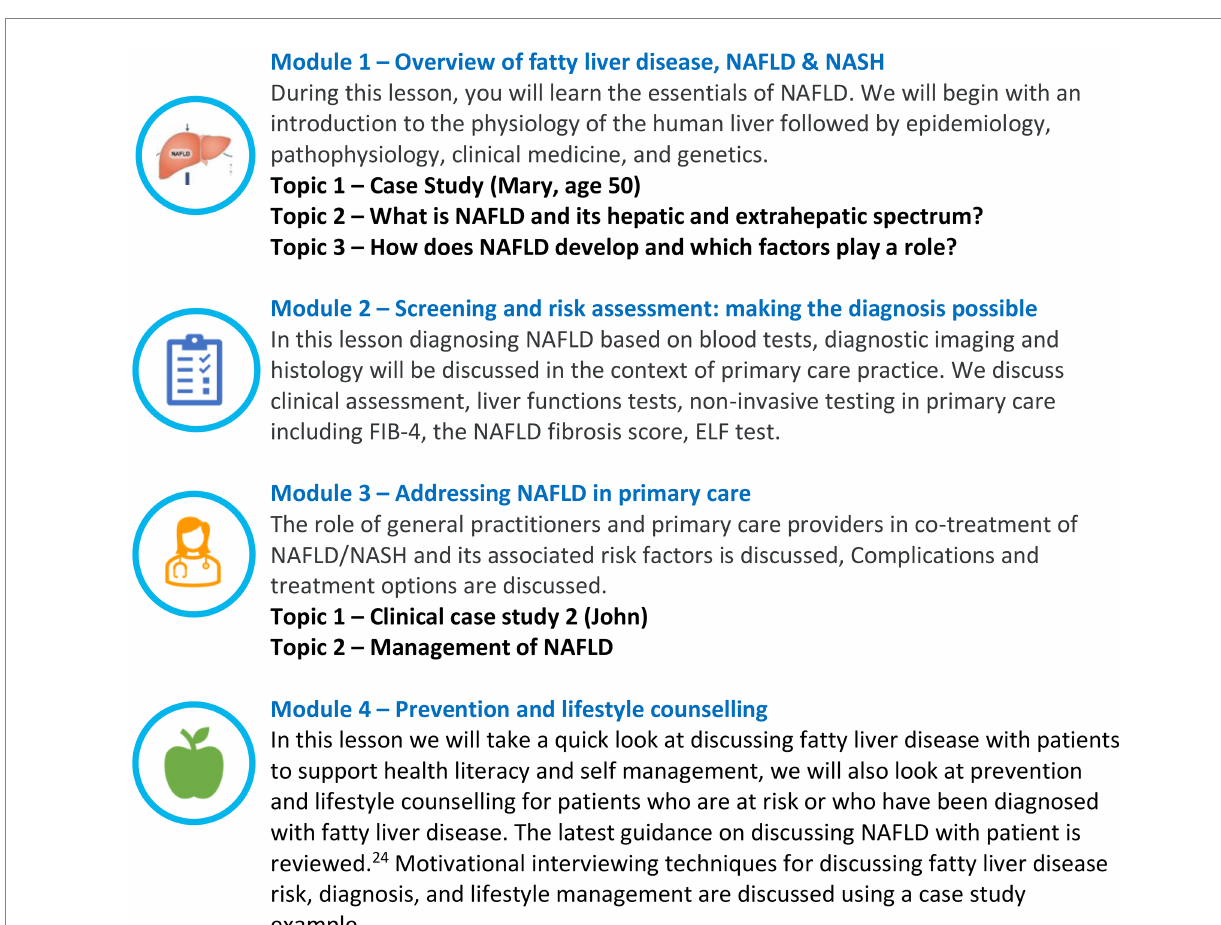
FIGURE 3 Continuing medical education (CME) content